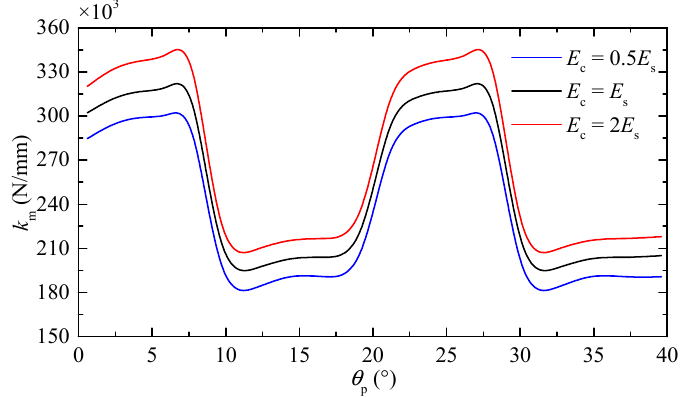
Figure 6. Gear mesh stiffness under different coating elastic moduli.